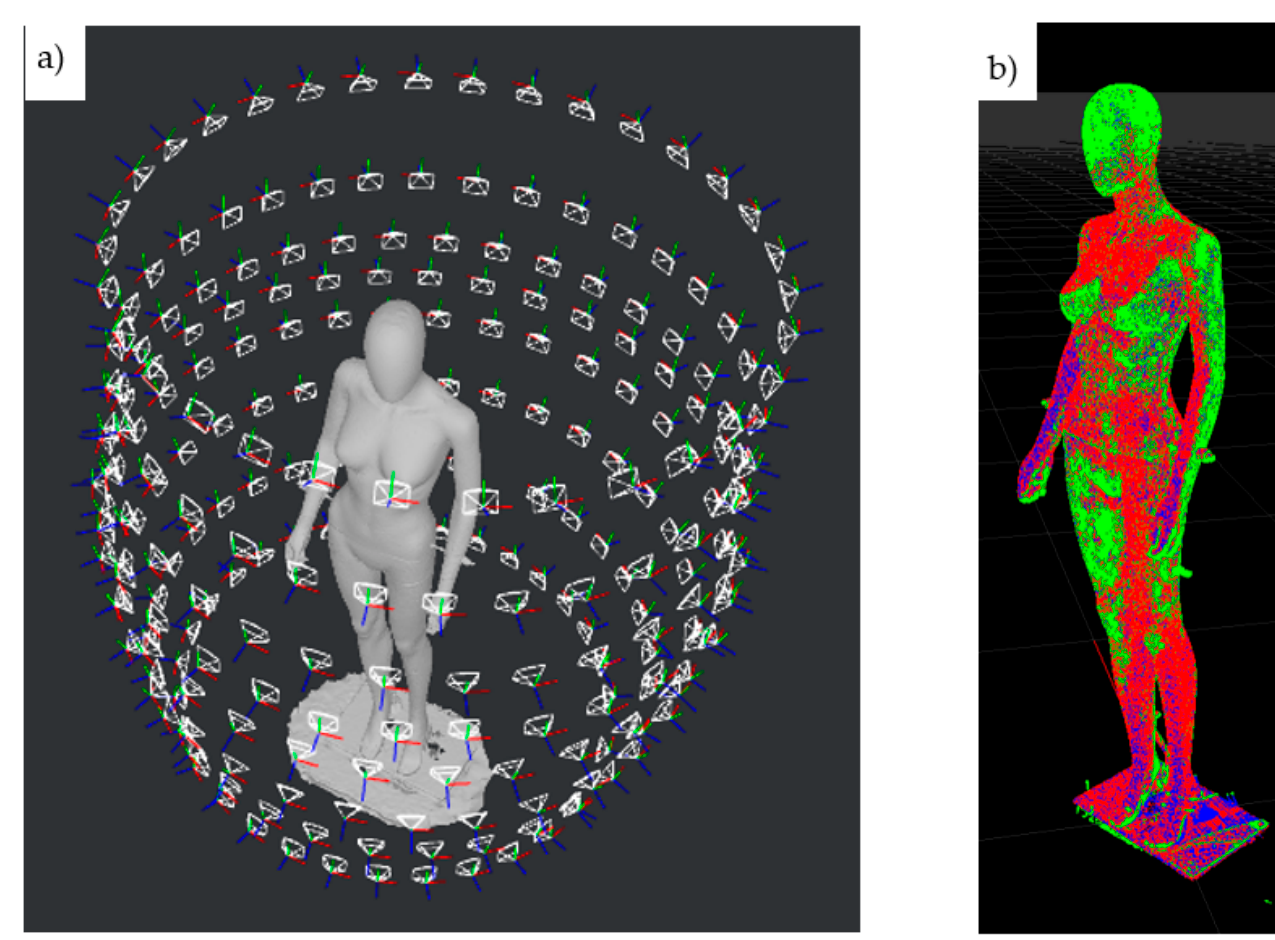
Figure 17. Sample results of dummy scanning with the use of HUBO scanner: ( a ) distribution of cameras around the scanned object obtained from the “structure from motion” algorithm, ( b ) the effect of comparing the scanning result with the reference 3D model.